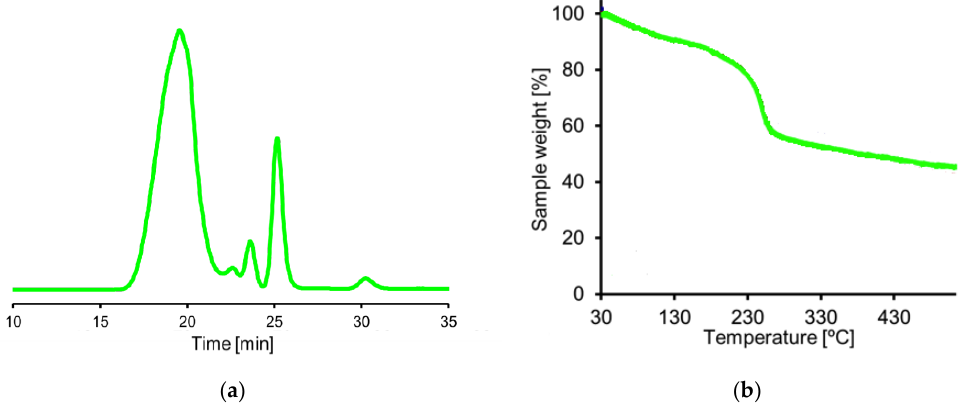
Figure 1. ( a ) Size Exclusion Chromatography-Multiple Angle Laser Light Scattering (SEC-MALLS) profile and ( b ) TGA of the sodium alginate from Sargassum